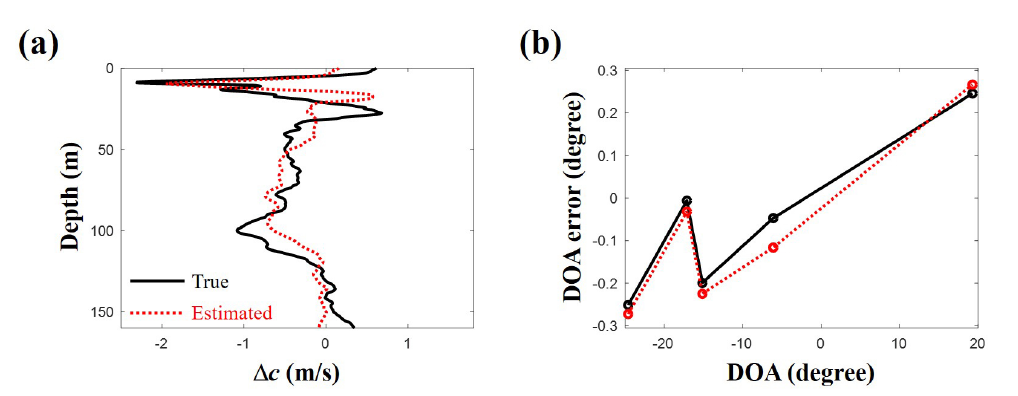
Figure 12. ( a ) sound speed differences from the reference sound speed profile estimated from compressive sound speed profile inversion with considering errors in arrival angles. Error angles are uniformly distributed between − 0.5 ◦ and + 0.5 ◦ ; ( b ) estimated errors in direction of arrivals used for the inversion. They are in good agreement with the actual